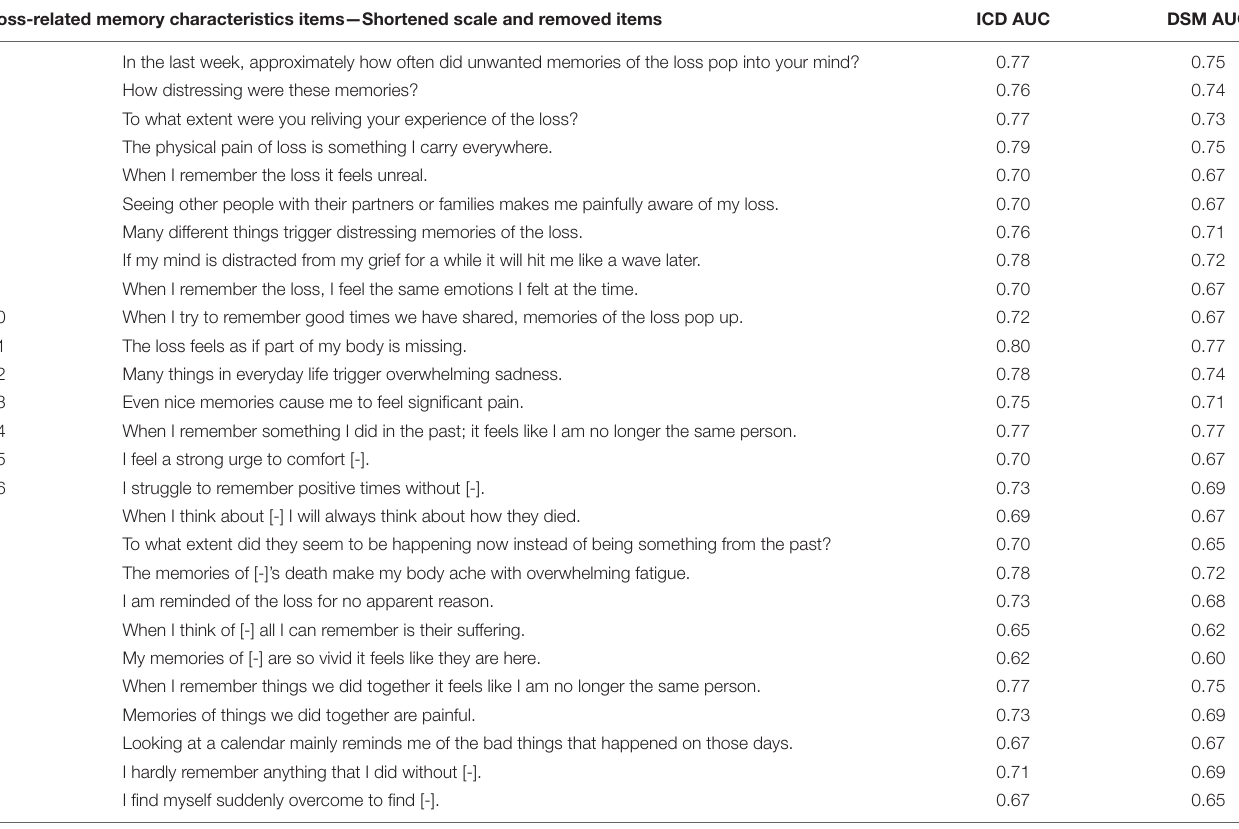
TABLE 4 | Area under the curve analysis of the OG-M items. Loss-related memory characteristics items—Shortened scale and removed items ICD AUC DSM AUC